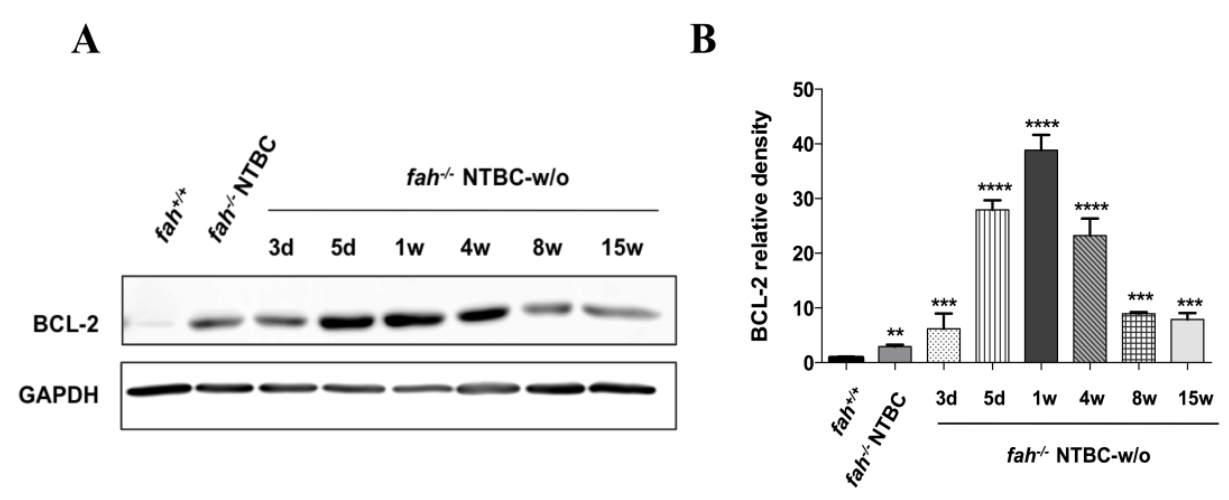
Figure 9. BCL-2 protein expression in HT1. ( A ) Levels of BCL-2 in livers of fah +/+ , fah −/− NTBC-treated and fah −/− NTBC-off mice; ( B ) Histogram shows quantitative representation of the BCL-2 protein level after normalization to levels of GAPDH. Fold-change protein level expression is reported in comparison to fah +/+ mice. Data are mean ± standard deviation for four samples. Significance of group differences was evaluated using